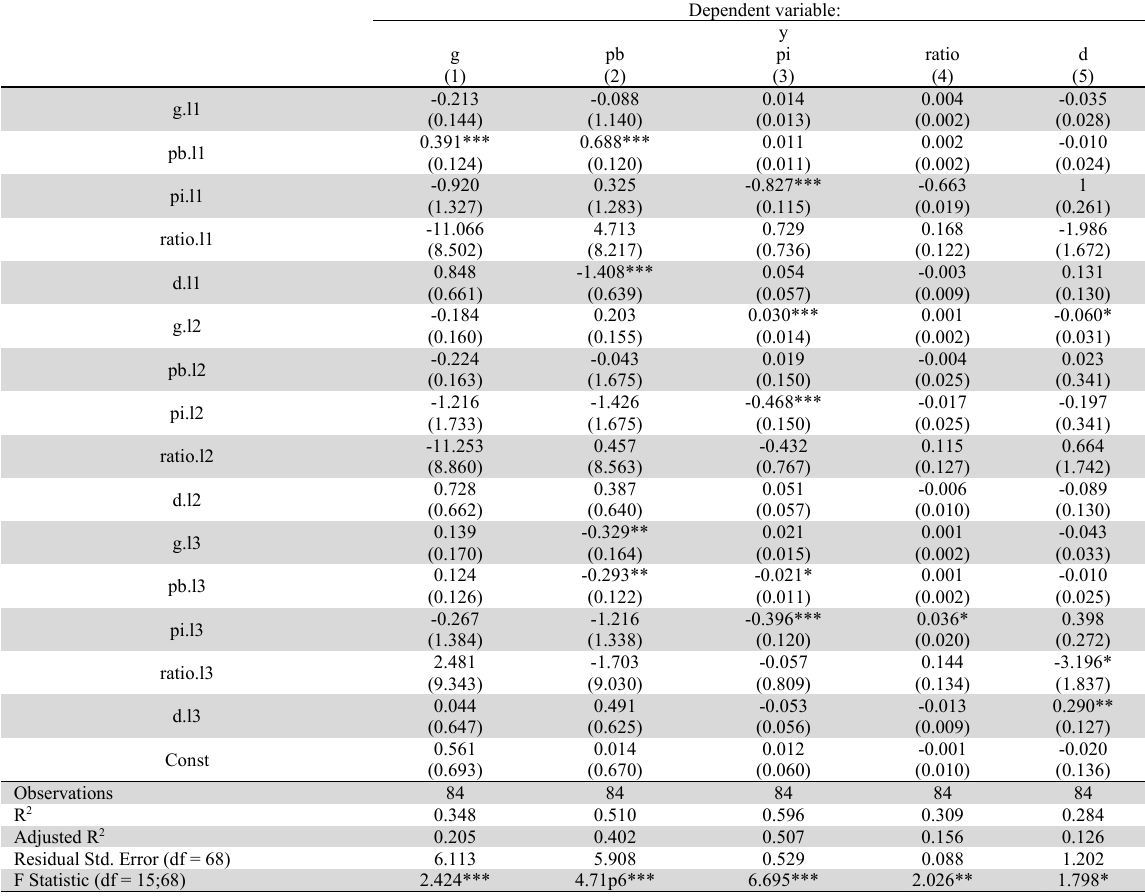
VAR Model Result